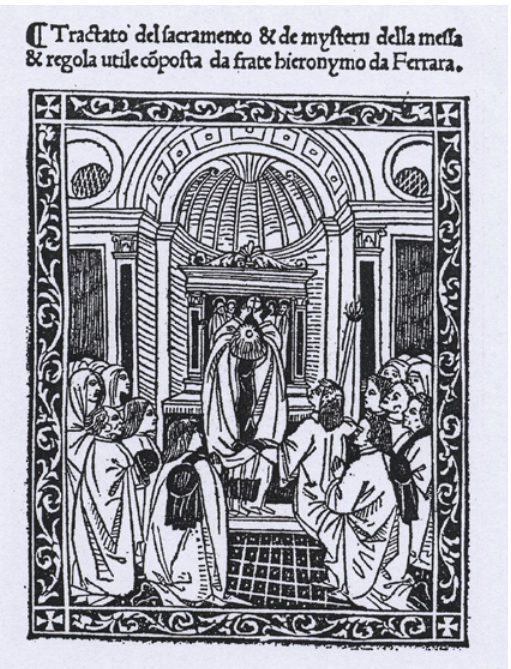
Figure 8 – Girolamo Savonarola, Tractato del sacramento & de’ mysterii della messa , s.n.t. [but Firenze, Bartolomeo de’ Libri, XV sec. ex .], f. 1r (BNCF, Cust. C 20). By permission of Ministero per i beni e le attività culturali / Biblioteca Nazionale Centrale. Firenze